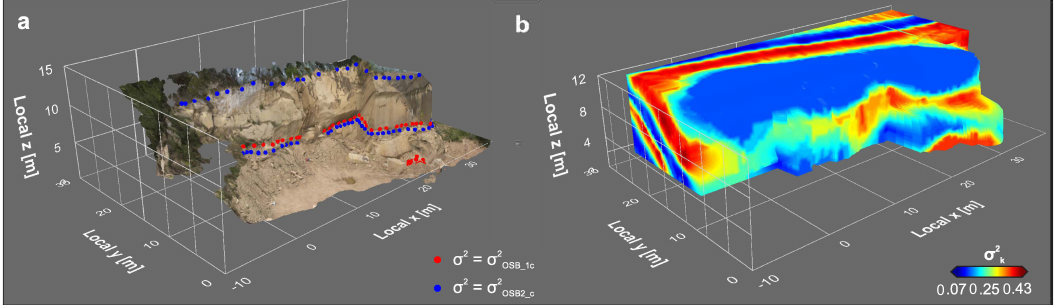
Figure 7. ( a ) Mapping of the local variance with regard to the observed geological structure. The highest variance is indicated by red spheres whereas the lowest variance is indicated by blue ones. The variance is derived from the rock cube measurements of OSB1_c—representing the most heterogeneous lithology at the bottom of the Bouma sequences (red)—and OSB2_c—likewise representing the most homogeneous lithology at the top of the Bouma sequences (blue). ( b ) The 3-D local variance model (LVM) representing the locally observable variance, which is constrained by the mappings shown in ( a